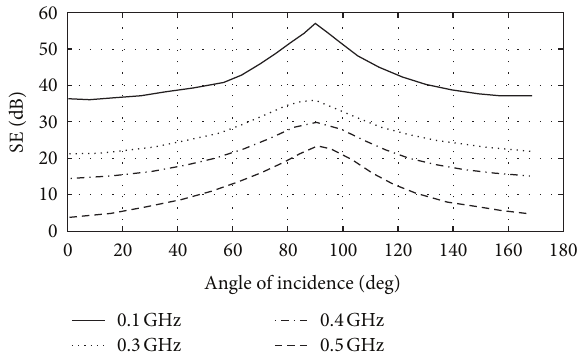
F 7: Shielding effectiveness of a box-shaped enclosure (30 elevation angle of incidence of the plane wave frequencies. × ×